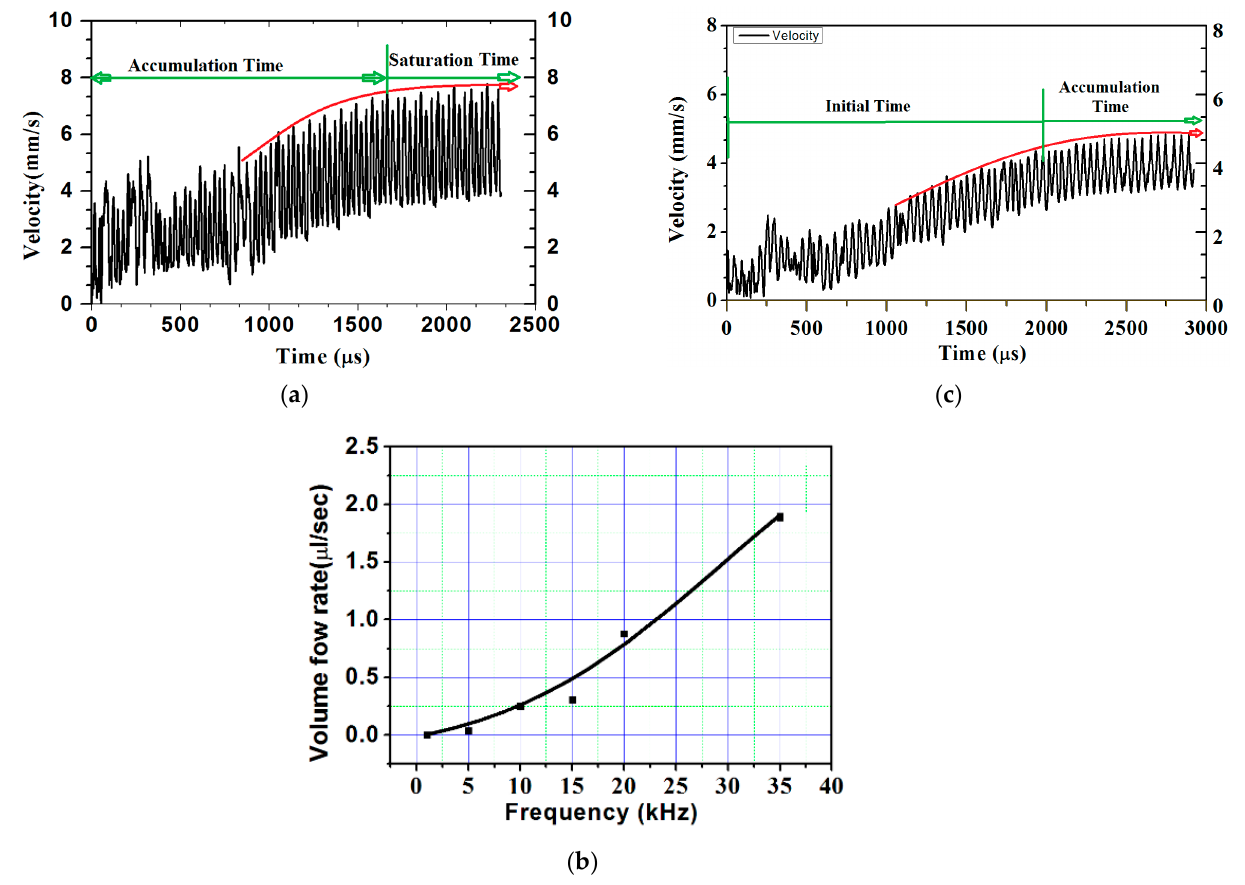
Figure 5. Velocity at biosensor location in the case of the 0.50-mm extended microneedle: ( a ) applied frequency of 35,338 Hz, ( b ) volume flow rate vs. applied frequency, and ( c ) applied frequency of 22,000 Hz.